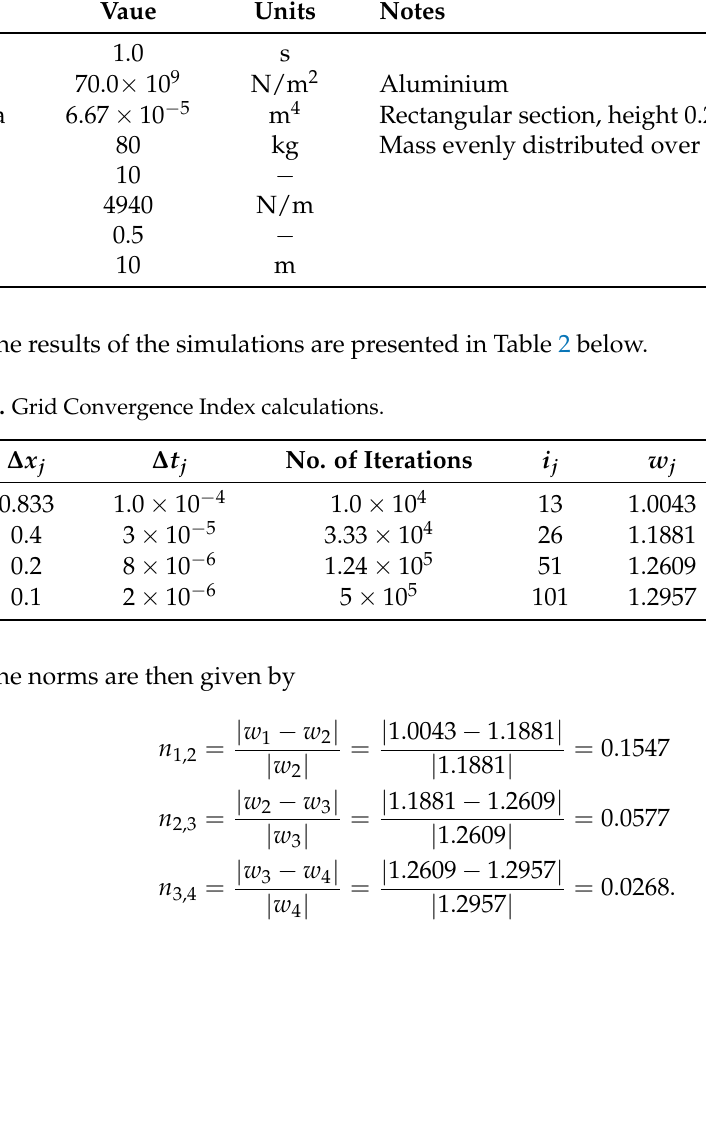
Table 1. Physical parameters used in the grid convergence study of the Euler–Bernoulli finite difference scheme. Symbol